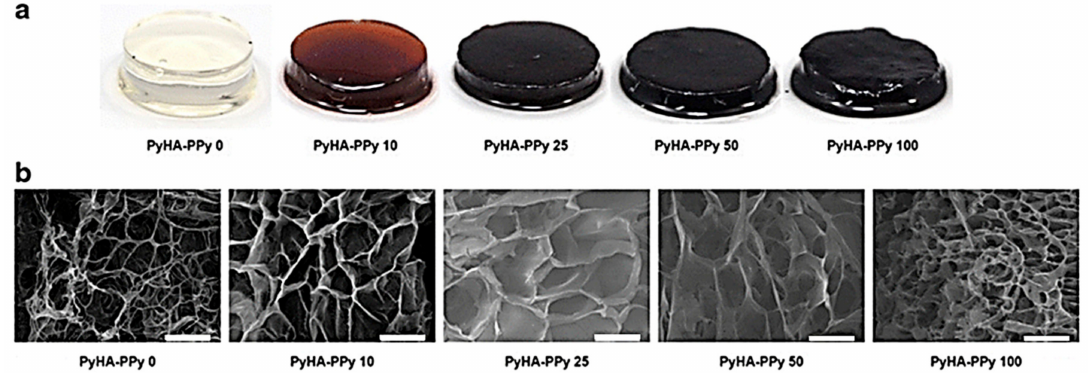
Figure 4. PPy/hyaluronic acid hydrogels; ( a ) various PyHA-PPy hydrogels and ( b ) SEM images of PyHA-PPy hydrogels. Scale bars are 50 µ m. (reproduced from [71] under open access